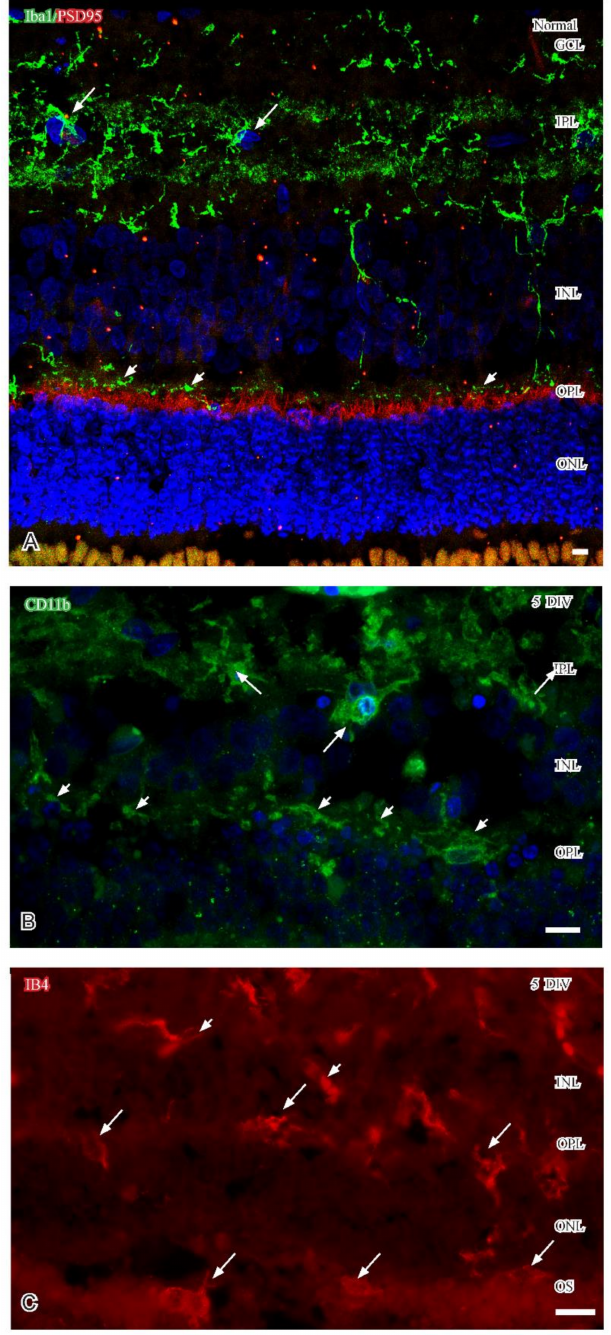
Figure 1. Confocal stacks ( A , B ) and fluorescence micrographs ( C ) of normal and 5 DIV retinas. ( A ) In normal healthy retina, Iba1 immunoreactive microglia (green: large arrows) localize to the IPL and project long, thin processes that finally arborize along the inner aspect (small arrows) of the PSD immunoreactive photoreceptor terminals (red) in the OPL. At 5 DIV ( C ), retinas CD11b immunoreactive microglia (green) are evident at the IPL (large arrows), close to photoreceptor terminals in the OPL (small arrows). Thick CD11b immunoreactive processes localize close to or within the OPL (small arrows). ( C ) 5 DIV retina with IB 4 labeled microglial cell bodies (large arrows) localized in the outer retina. Note also labeled degenerating capillaries (small arrows). DAPI counterstaining in ( A , B ). Abbreviations. GCL ganglion cell layer; INL inner nuclear layer; IPL inner plexiform layer; ONL outer nuclear layer; OPL outer plexiform layer; OS outer segments. Scale ( A – C ) 10 µ